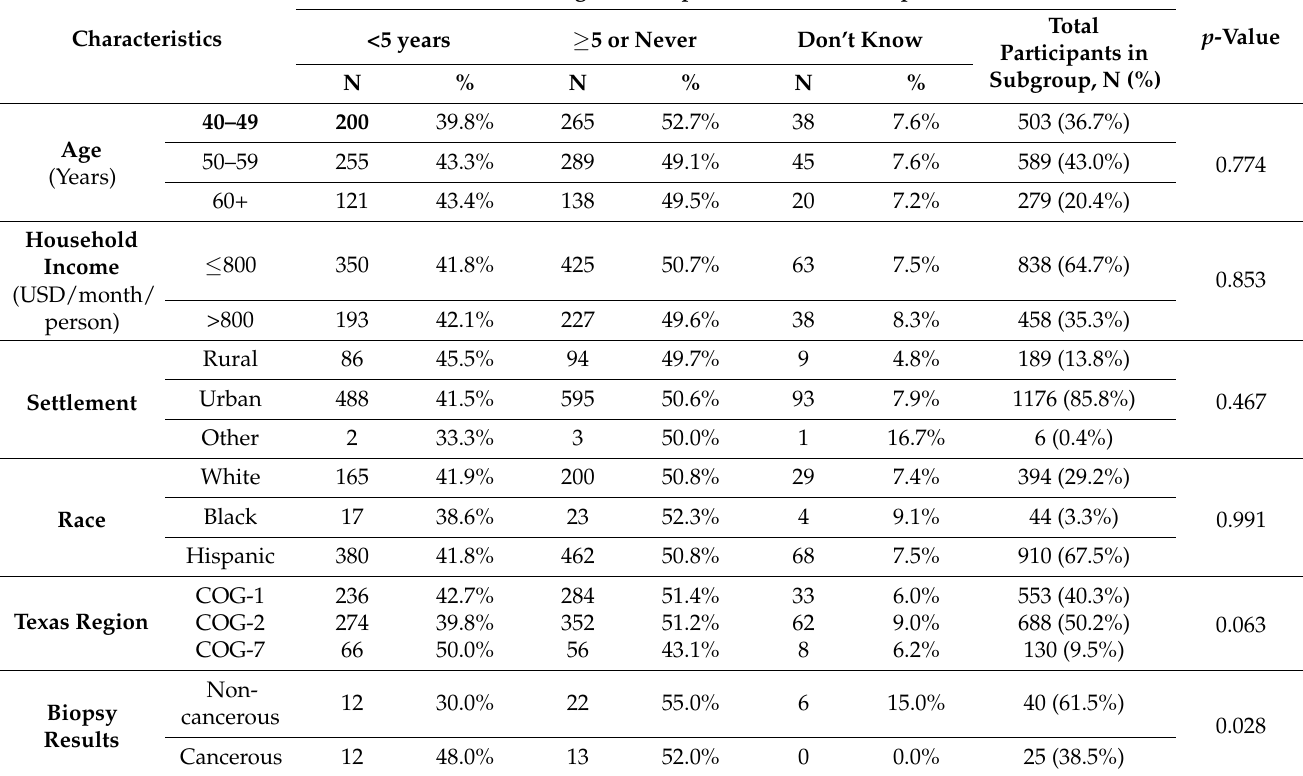
Table 1. Factors associated with baseline compliance with mammogram screening according to American College of Radiology